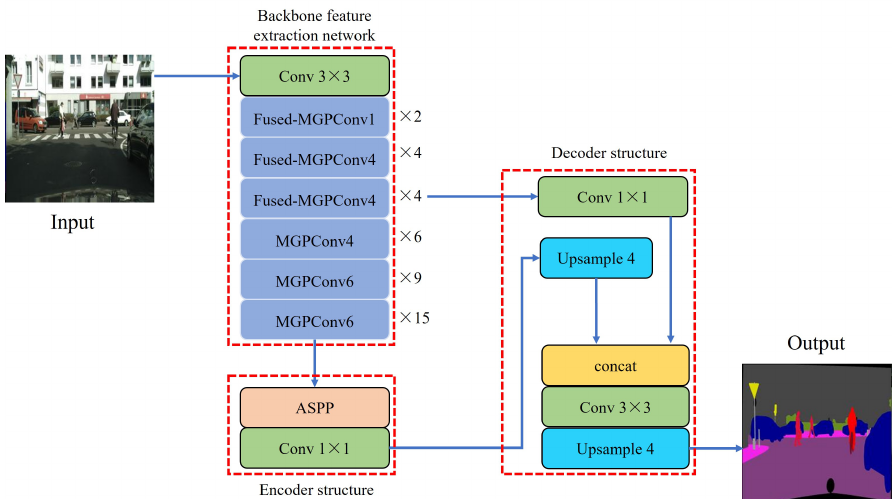
Figure 10. Overall structure of the EfferDeepNet network.